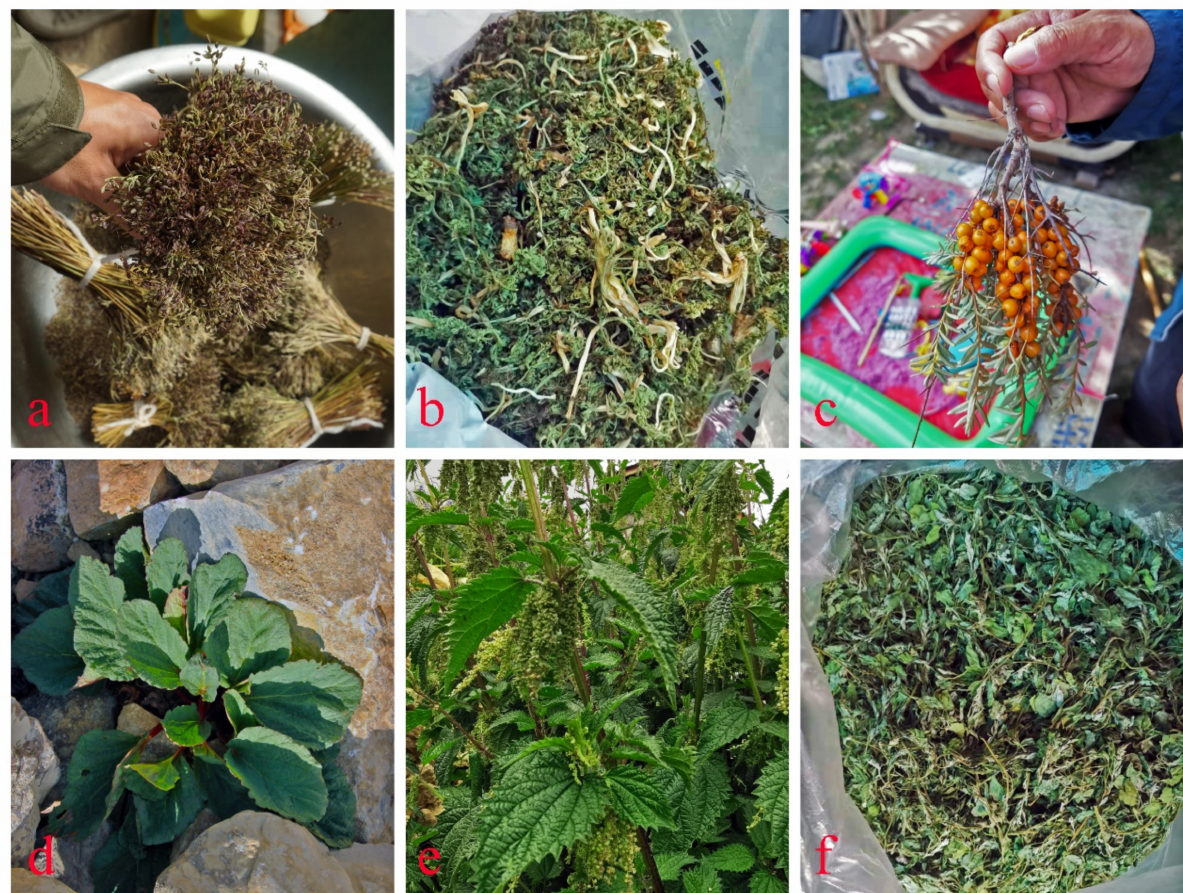
Figure 7. The top five wild plants used by Tibetans. ( a ): The seeds of Carum carvi ; ( b ): the tender leaves of Carum carvi ; ( c ): the fruits of Hippophae tibetana ; ( d ): Rheum moorcroftianum ; ( e ): Urtica dioica ; ( f ): the tender leaves of Chenopodium album